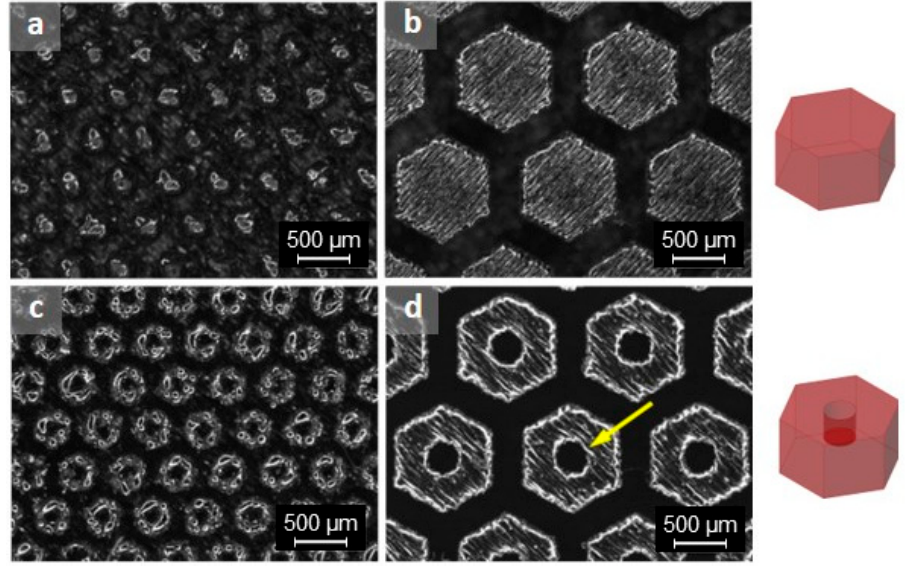
Figure 2. Hex samples at ( a ) Scale 1 and ( b ) Scale 5; Hex-D samples at ( c ) Scale 1 and ( d ) Scale